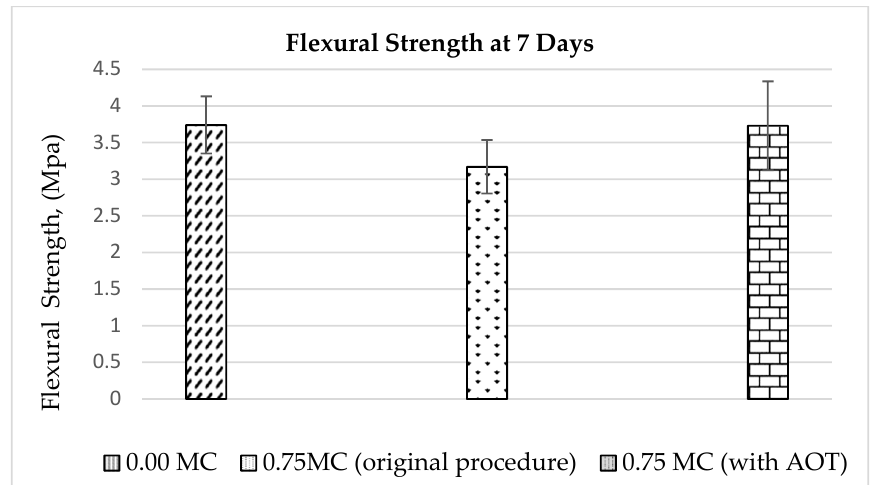
Figure 4. Compressive strength versus microcapsule concentration at 7 curing days (Error bars = standard deviation).